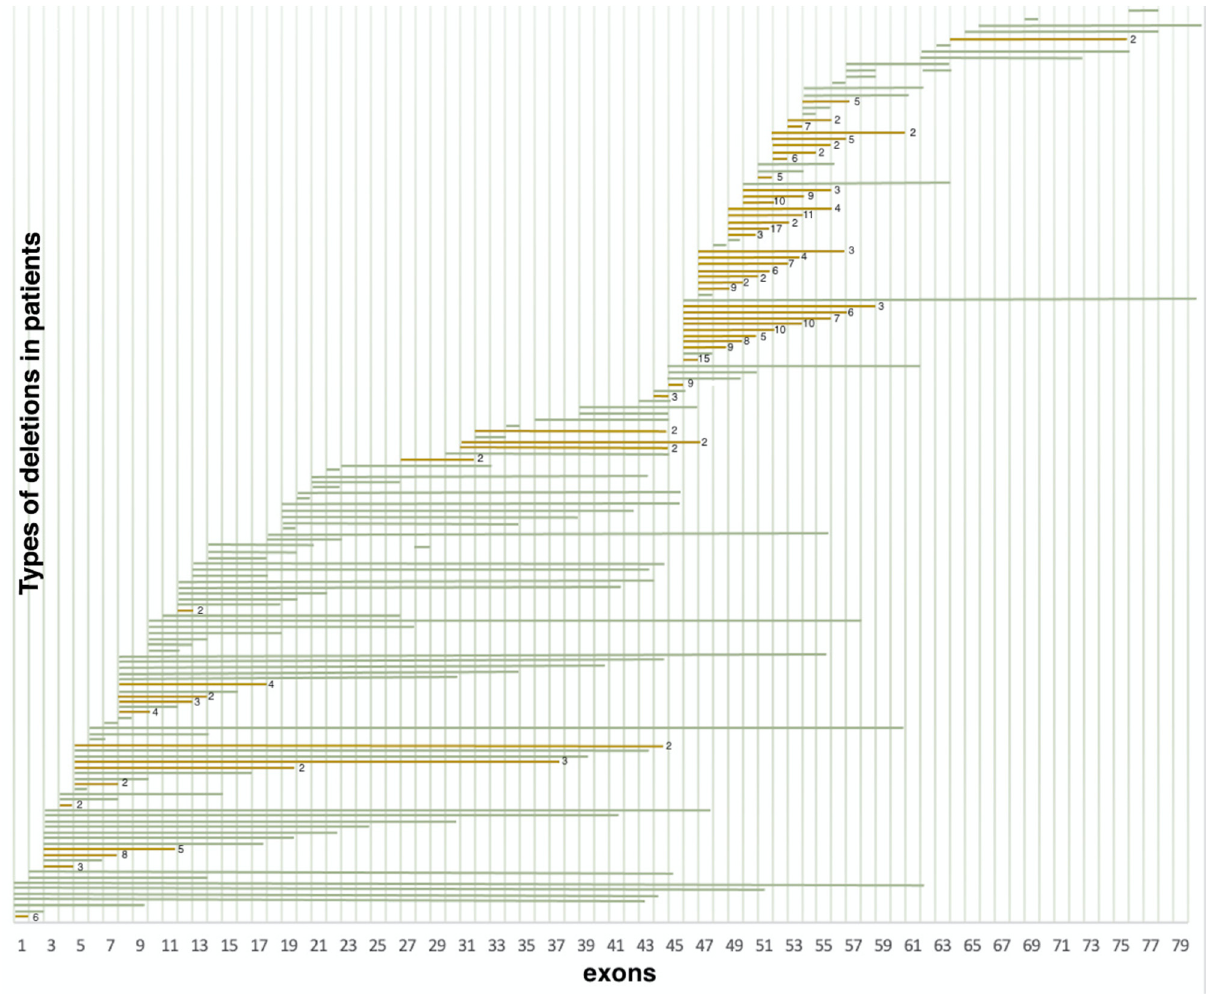
Figure 2. Distribution of deletions in various exons ( n = 386) (green represents deletions encountered once, yellow represents deletions encountered multiple times).